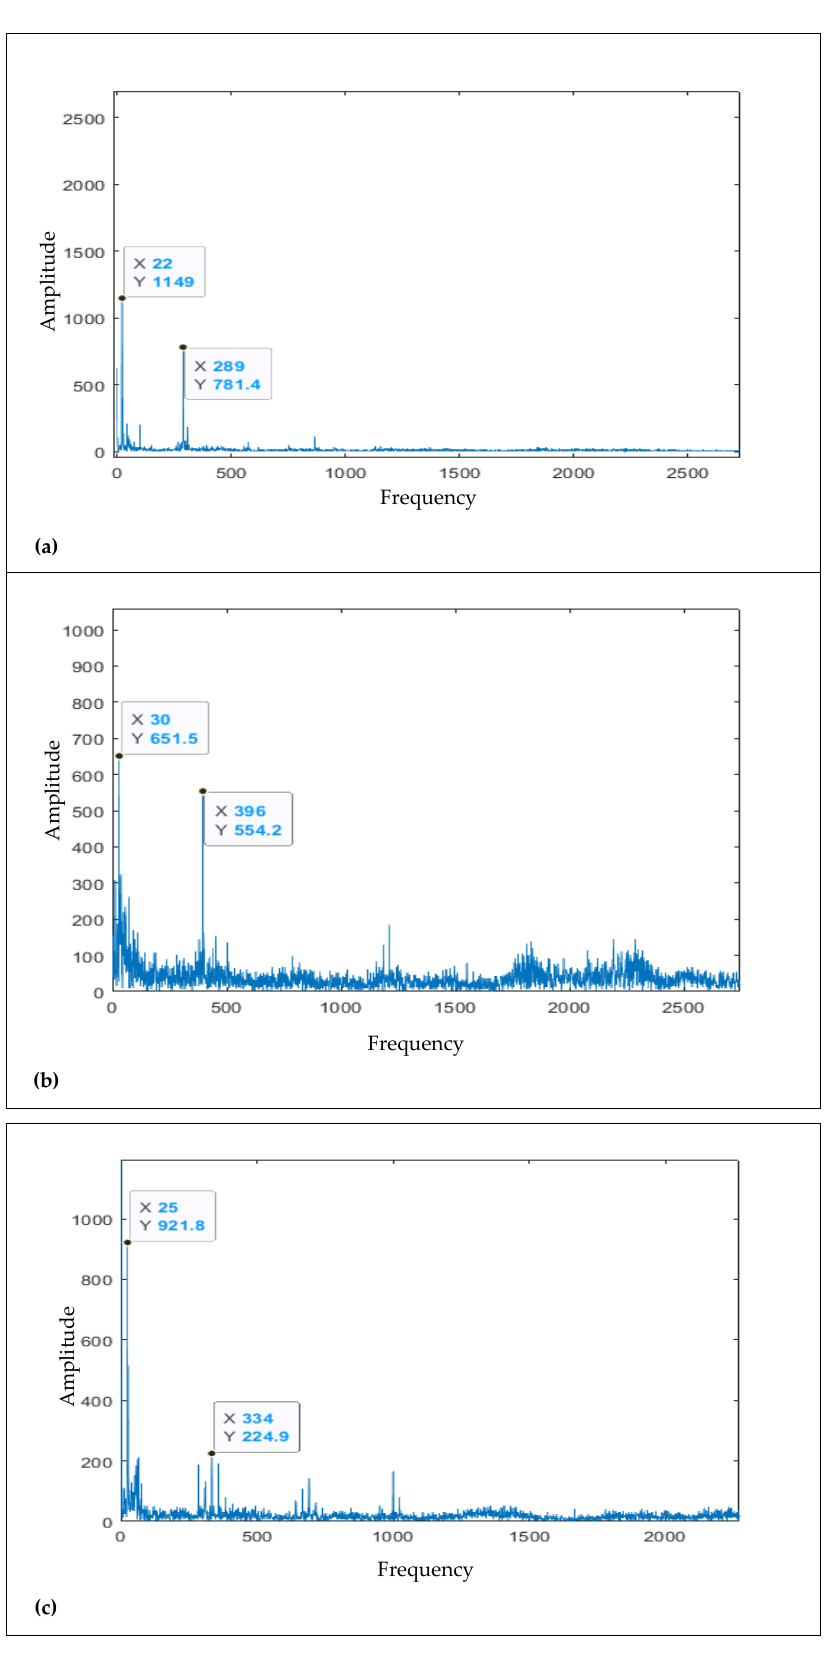
Figure 2. The frequency spectra of the vibrations collected for time measurement ( a ) 58, ( b ) 650, ( c ) 892 for channel 3 of the 2014 datasets.